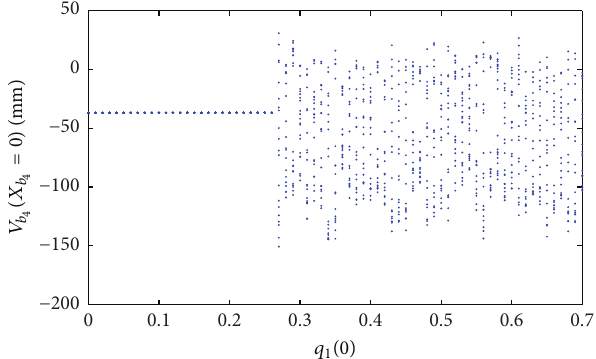
Figure 14: Bifurcation diagram of the cable-stayed bridge with respect to 𝑞 1 (0) , 𝑞 𝑟 (0) = 𝑞 1 (0)𝛿 1𝑟 and 𝑁 = 11 .